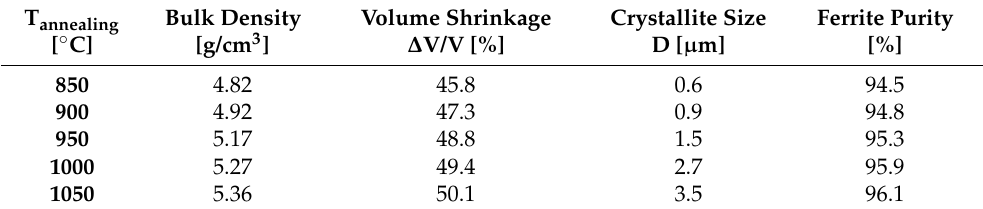
Table 1. Structural characteristics of Mg 0.5 W 0.5 Fe 2 O 4 ferrite samples.